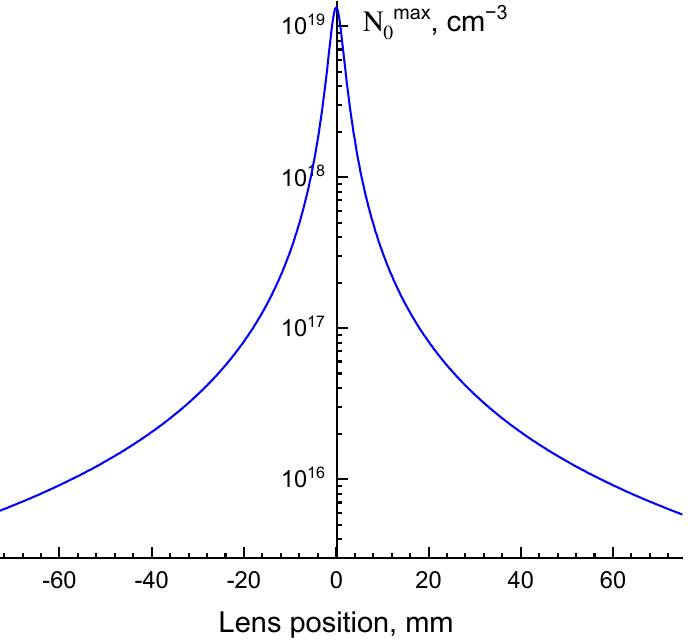
Figure 1. Dependence of maximal density of excitations on the translation of the focusing lens along the Z-axis of the laser beam, E = 20 nJ.